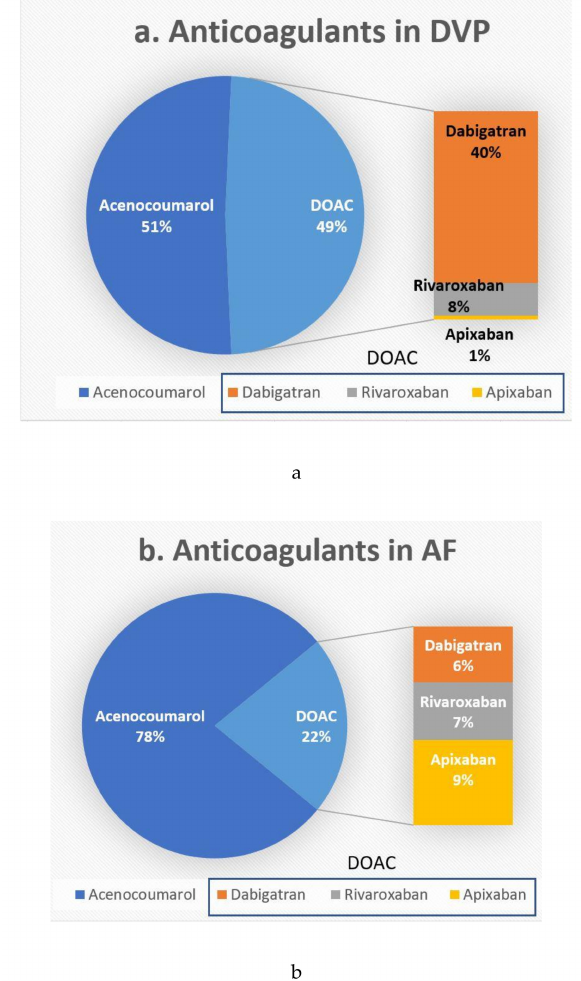
Figure 2. Anticoagulant choice. DOAC—direct oral anticoagulant ( a ). DVP—deep vein thrombosis ( b ). AF—atrial